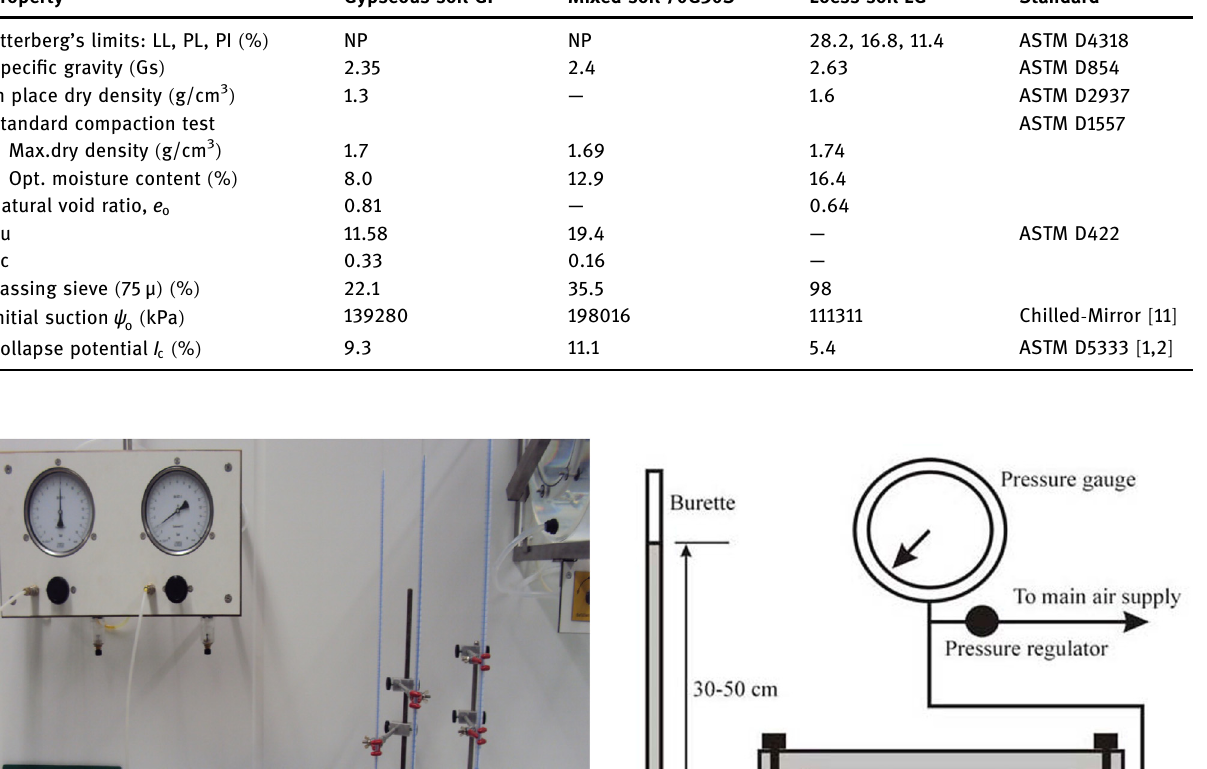
Table 1: Summary of the geotechnical properties of the soil samples Property